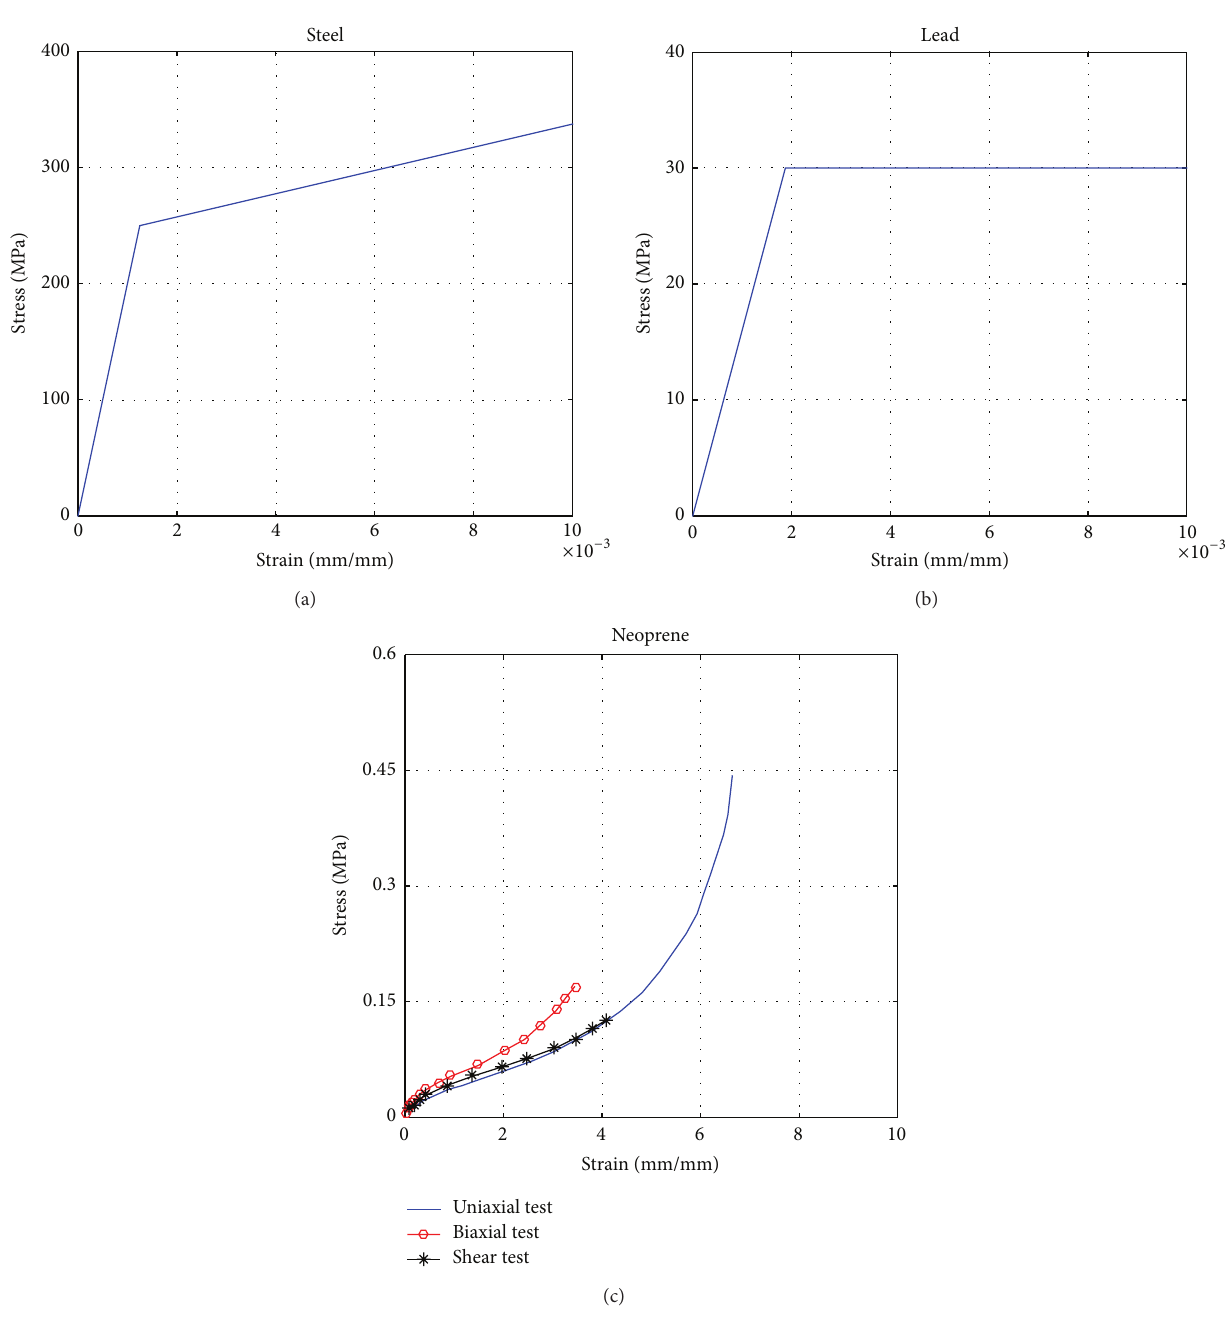
Figure 2: LRELS material properties.